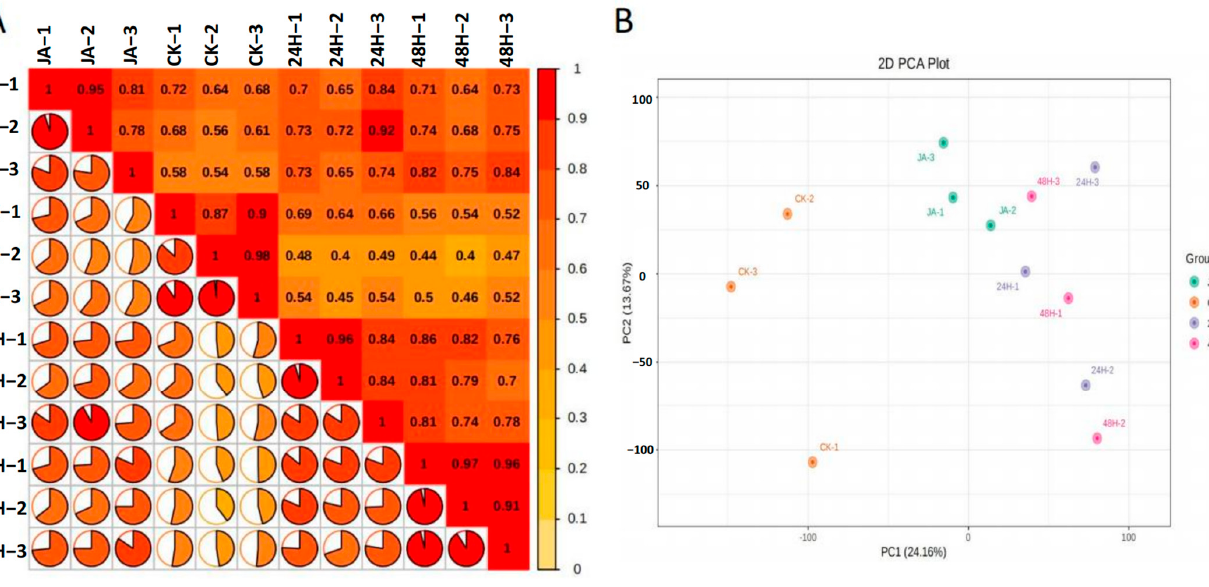
Figure 2. ( A ) Sample correlation diagram. ( B ) Sample PCA diagram.